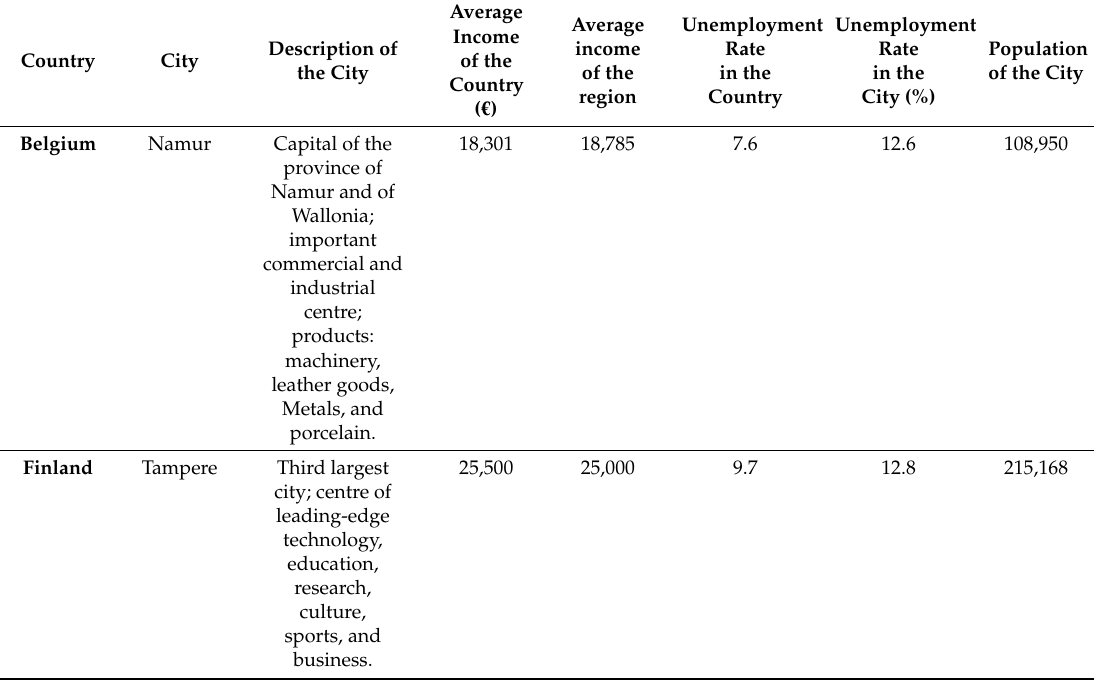
Table A1. Socioeconomic characteristics of the cities surveyed in the six countries in 2013 [38].